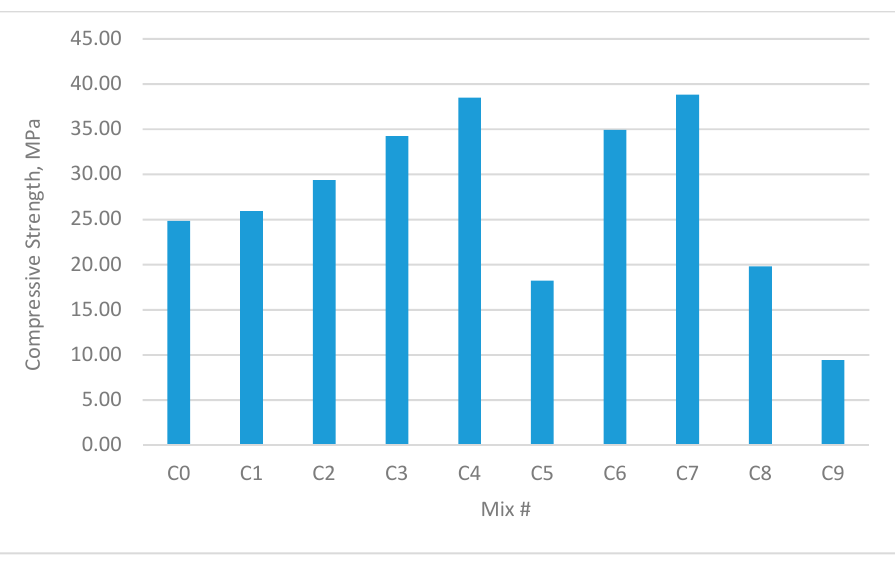
Figure 3. Uniaxial compressive strength of concrete beams with W/B ratio 0.3.